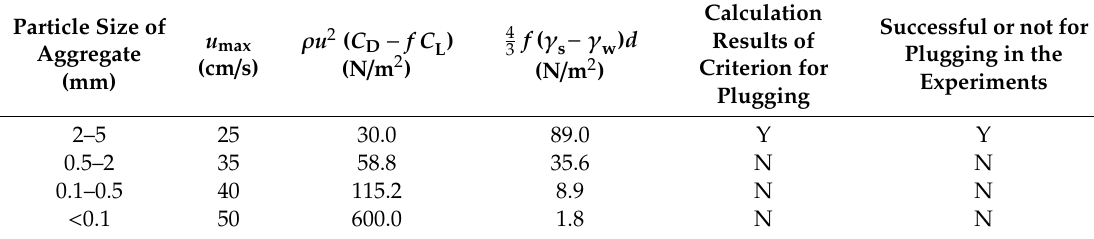
Table 5. Analysis of plug criterion of section of tunnel that resists water flow under dynamic